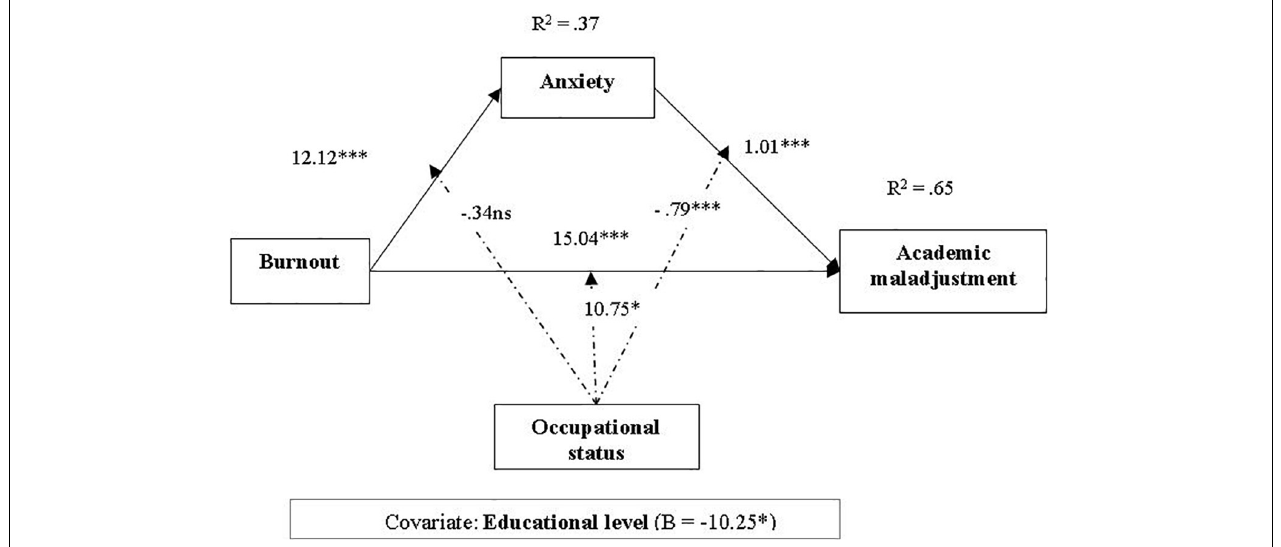
FIGURE 2 | Moderated mediation model of relationship between burnout and academic maladjustment (mediator: test anxiety; moderator: occupational status). n.s. = not significant, * p < 0.05, ** p < 0.01, *** p < 0.001.